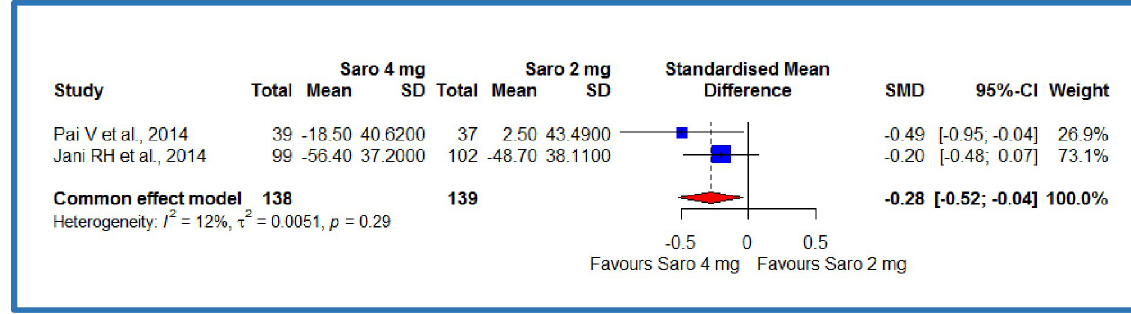
Fig 4. Forest plot of comparison of saroglitazar 4mg versus saroglitazar 2mg on total cholesterol (mg/dL).